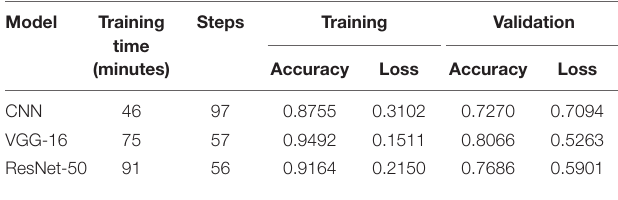
TABLE 3 | Summary of training and validation